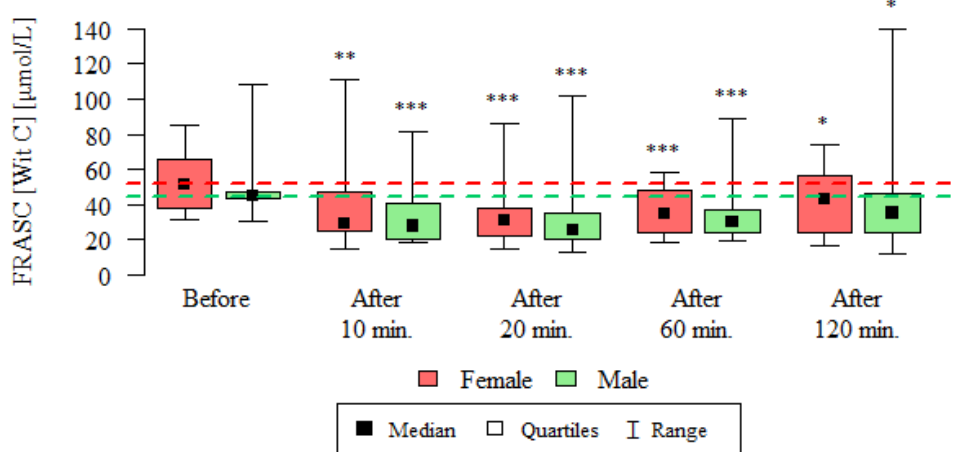
Figure 5. Total antioxidant capacity expressed as FRASC (vitamin C) [µmol/L] in the blood of subjects undergoing routine HRCT examination before the test, 10 min, 20 min, 60 min and 120 min after the test. The analysis was carried out using the Wilcoxon test for dependent (repeated) measurements; the graph shows the medians, quartiles and ranges of values of individual variables. * p —comparison with the measurement before the examination (* p < 0.05, ** p < 0.01, *** p < 0.001)—Wilcoxon test for dependent (repeated) measurements. Table 4. Correlation between FRAP and FRASC values in patients undergoing routine HRCT before the test, 10, 20, 60 and 120 min after the